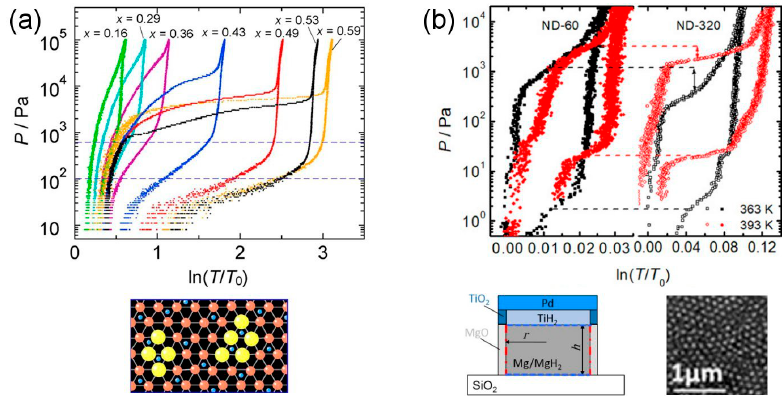
Figure 9. Pressure-optical transmission isotherms on fully embedded Mg nano-objects. ( a ) Mg x Ti 1 − x -H 2 systems at 120 °C: for small x, Mg or MgH 2 nanoclusters were embedded in a TiH 2 matrix (yellow atoms in the schematic bottom image, estimated cluster radius was ≈ 1 nm). The dashed lines indicate the hydrogen absorption and desorption pressures for a 60 nm thick Mg film. Reprinted with permission from Ref. [60]. Copyright 2015 American Chemical Society; ( b ) Mg (30 nm)/Ti (5 nm)/Pd (5 nm) nanodots (see sketch and electron microscopy image at the bottom) with different diameters 2 r = 60 (ND-60) and 320 nm (ND-320). The black (red) points were measured at 90 °C (120 °C). Adapted with permission from Ref. [35]. Copyright 2016 Hydrogen Energy Publications